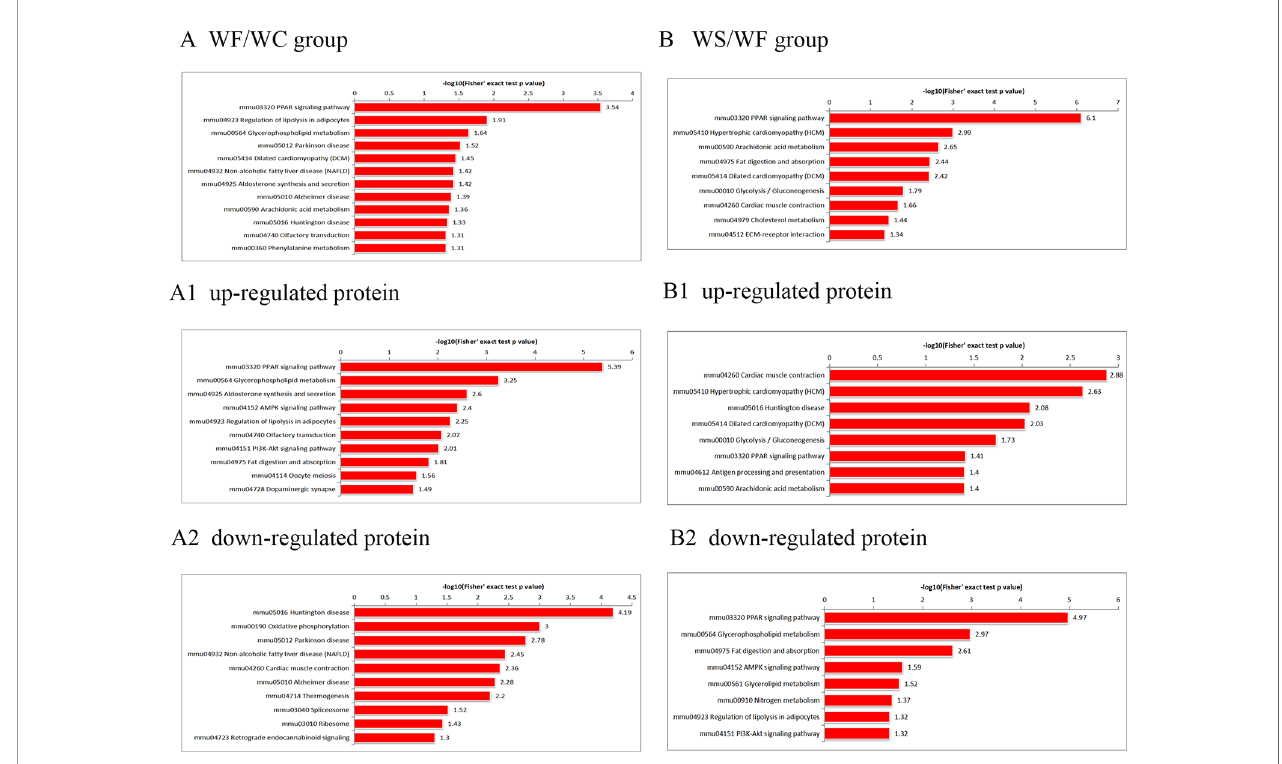
FIGURE 7 | The KEGG pathway enrichment of differentially expressed proteins. (A) In WF/WC group, differentially expressed proteins were involved in PPAR, lipolysis of fat cells, metabolism of glycerides, Parkinson's disease, and dilated cardiomyopathy pathways; (A1) The pathway of up-regulated proteins; (A2) The pathway of down-regulated proteins; (B) In WS/WF group, the differential proteins were mainly concentrated in PPAR, hypertrophic cardiomyopathy, arachidonic acid metabolism, fat digestion and absorption, and dilated cardiomyopathy metabolic pathway; (B1) The pathway of up-regulated proteins; (B2) The pathway of down-regulated proteins; WC, normal diet; WF, high fat diet; WS, high fat diet +